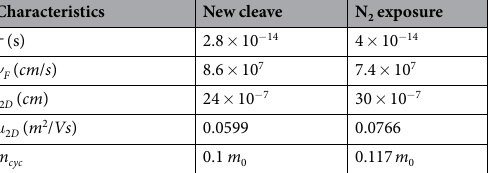
Table 1. The extracted carrier characteristics of surface state in the same sample with different level of N 2 exposure.